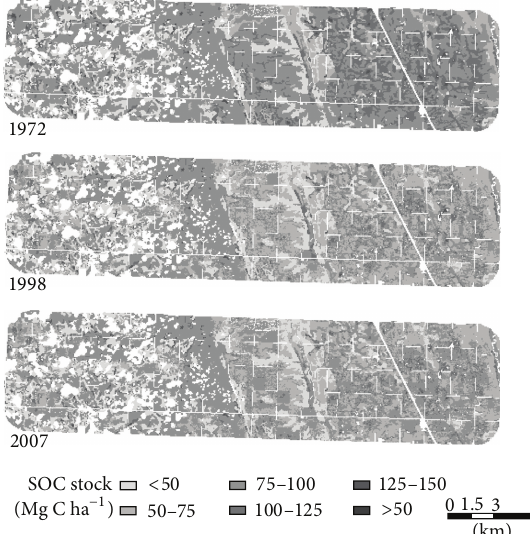
Figure 4: The spatial distribution of the SOC stock magnitudes across the study area in 1972, 1998, and 2007.